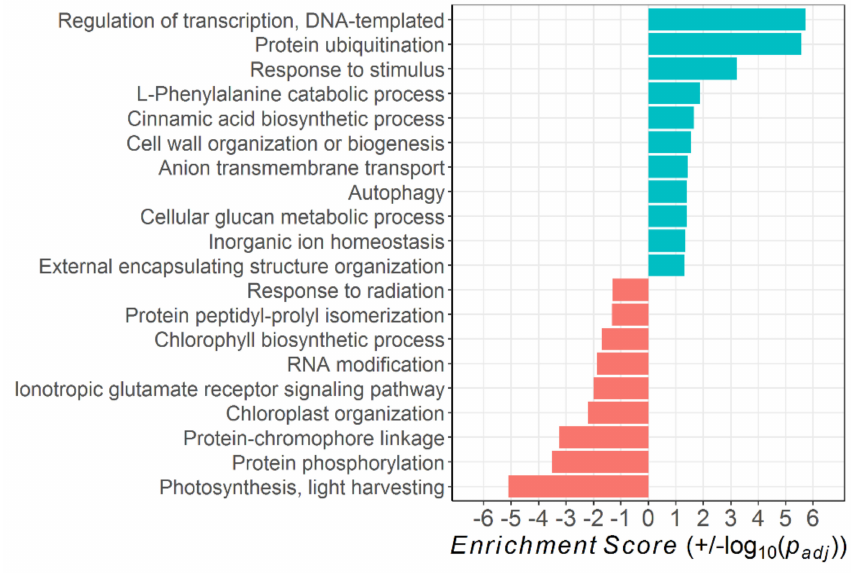
Figure 5. Significantly up- and downregulated ( p adj < 0.05) Gene Ontology biological processes in leaves of naturally senescing vs. control Vitis vinifera cv. Riesling vines. The Enrichment Score gives the log 10 of the p adj -value according to Fisher’s Exact Test